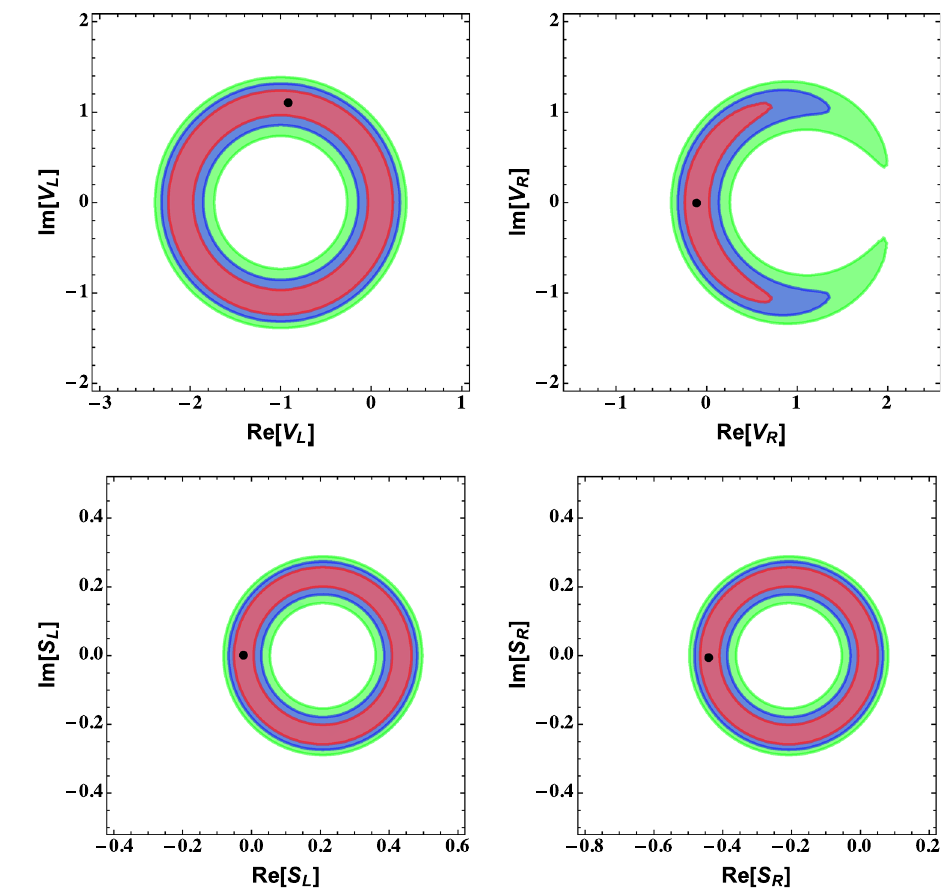
Fig. 2 Constraints on individual new complex coefficients associated with